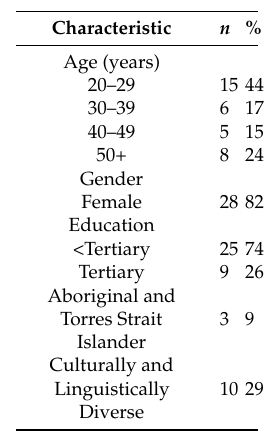
Table 2. Characteristics of ‘at risk’ ( n =